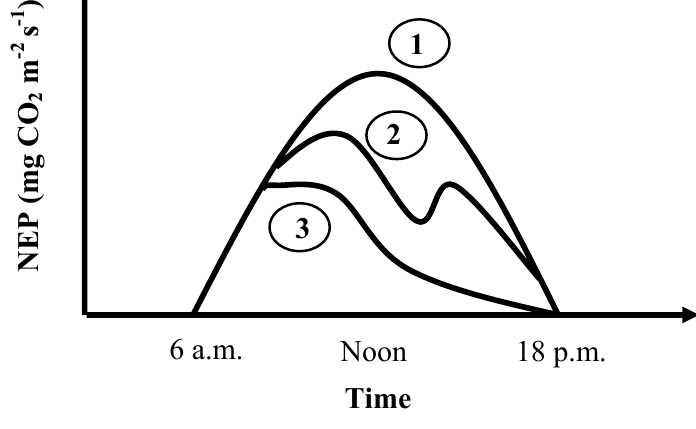
Figure 2. Three patterns of diurnal variation in net ecosystem production for the photosynthesis. Pattern 1: a single diurnal peak, indicating that no stress occurs; Pattern 2: two diurnal peaks, which is a common occurrence in nature; and Pattern 3: one peak with severe midday depression, which occurs mostly in drought